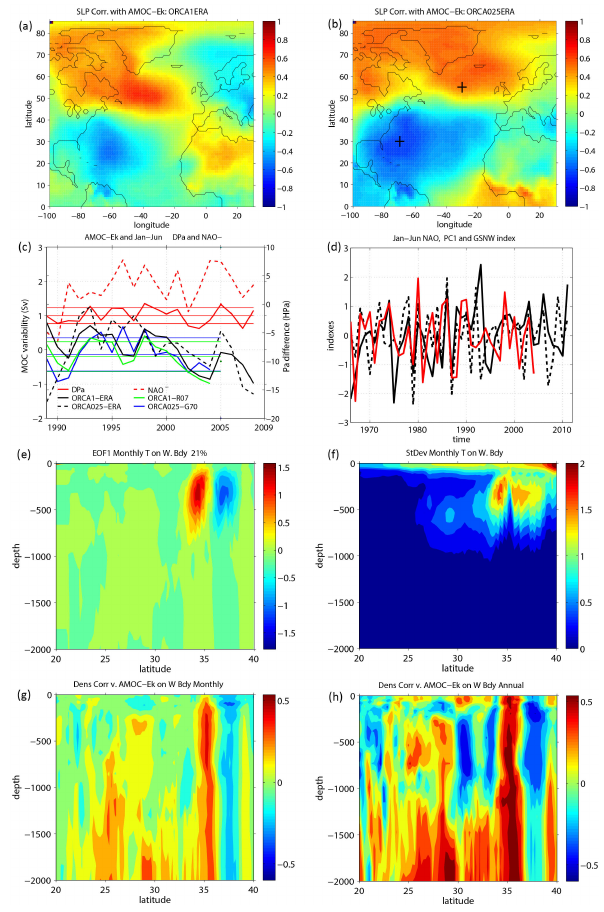
Figure 6. Correlation of sea level pressure with ORCA1-ERA (a) and ORCA025-ERA (b) AMOC-Ek transport for 1989–2008; (c) annual ORCA1-ERA (black), ORCA025-ERA (dashed black), ORCA1-R07 (green) and ORCA025-G70 (blue) AMOC-Ek trans- ports at 26.5 ◦ N (in Sv), and January–June mean 1 Pa (red, in hPa; see text) and January–June mean NAO − index (dashed red). Hori- zontal lines show mean values plus and minus standard deviations (for curves corresponding to the same colours); (d) January–June mean NAO index (black solid), PC1 (red; see text) and annual Gulf Stream north wall index (black dashed); (e) the first leading EOF mode (EOF1) of monthly temperature anomalies at the west- ern boundary; (f) standard deviation of monthly temperature at the western boundary; (g, h) correlations of the AMOC-Ek at 26.5 ◦ N with density at the western boundary in ORCA025-G70 for the 45-year period 1960–2004 inclusive from monthly (g) and annual mean (h) data. For panels (d – h) , variability on periods longer than 12 months have been filtered